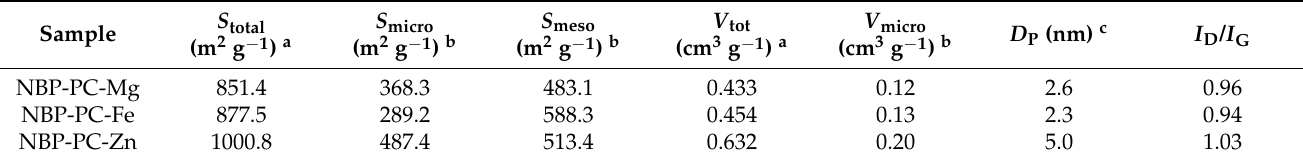
Table 1. Physical properties of the as-prepared